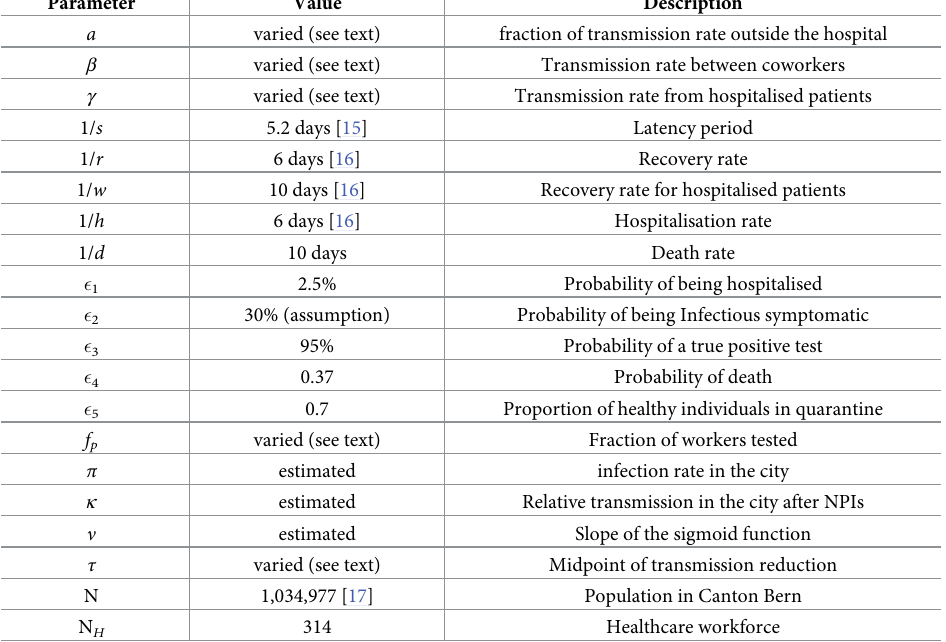
Table 2. Parameters of the